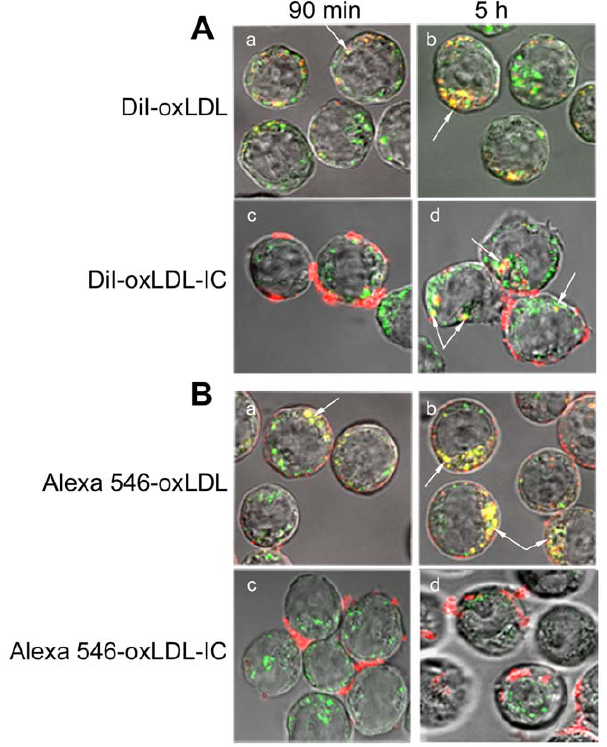
Figure 3. Localization of labeled lipoprotein moieties of oxLDL and oxLDL-IC in lysosomal compartment. U937 cells were treated with either DiI-labeled lipid moiety (red) ( A ), or Alexa 546-labeled protein moiety (red) ( B ) for 90 min and 5 h, with lysosomal marker (Lyso Tracker Green DND-26, 50 nM) applied for the last 30 min of incubation. Cells were treated with labeled oxLDL and oxLDL-IC at 18 m g/ml and 24 m g/ml, respectively. Live cells were washed with DPBS then suspended in sealed capillaries and visualized using confocal microscopy. Arrows point at co-localization of lipid and apolipoprotein moieties of oxLDL and oxLDL-IC with lysosomal compartment.